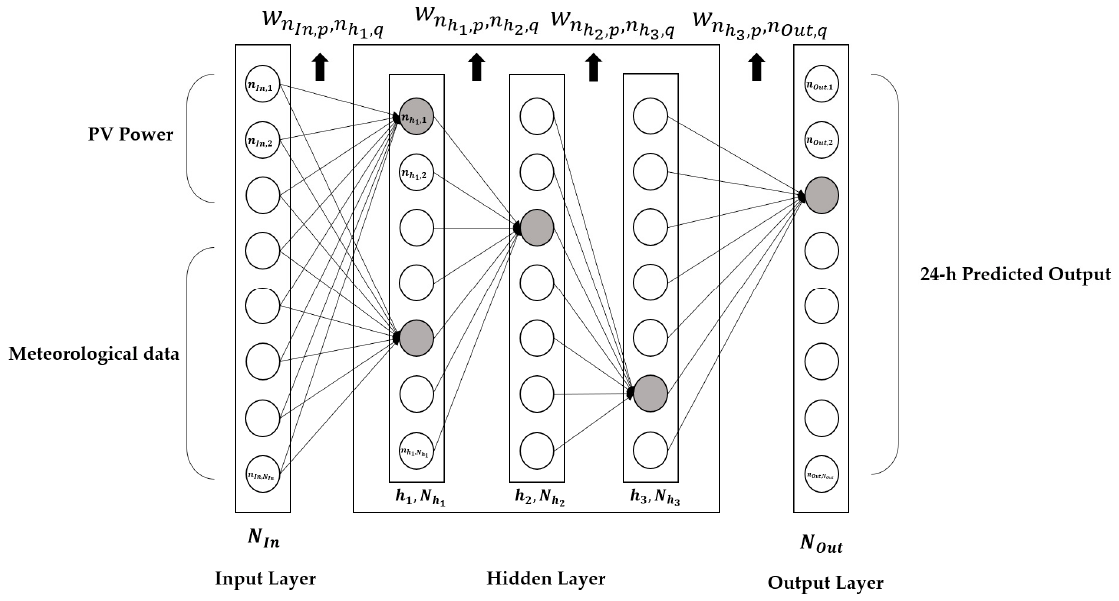
Figure 1. Deep Neural Network ( DNN) based model architecture.